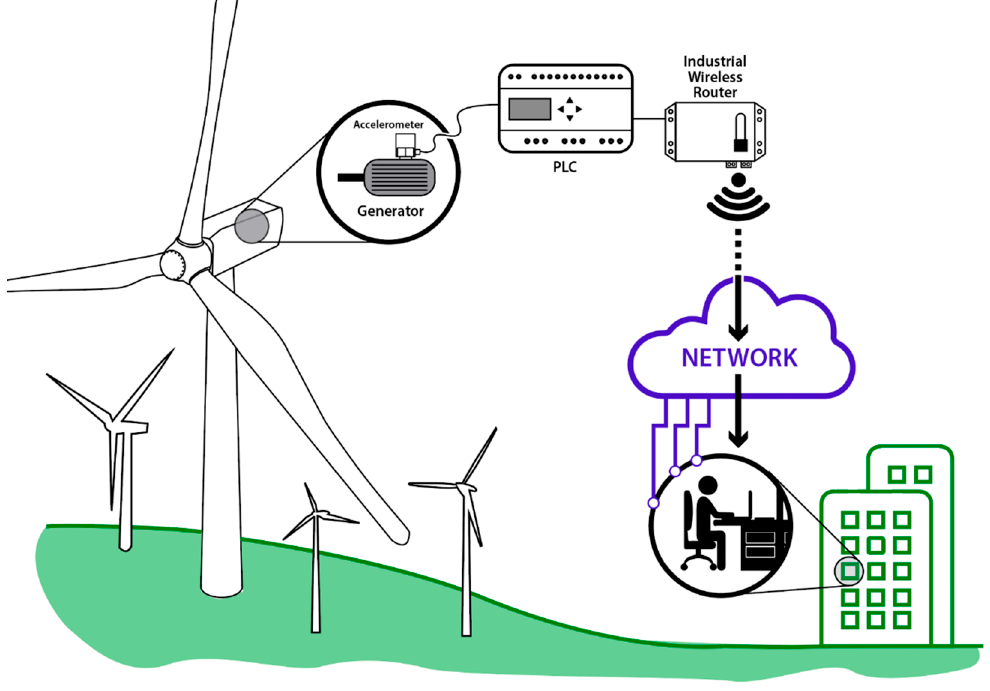
Figure 6. Frequency-signal processing pipeline, from signal capture in the nacelle generator to its recording in the office.